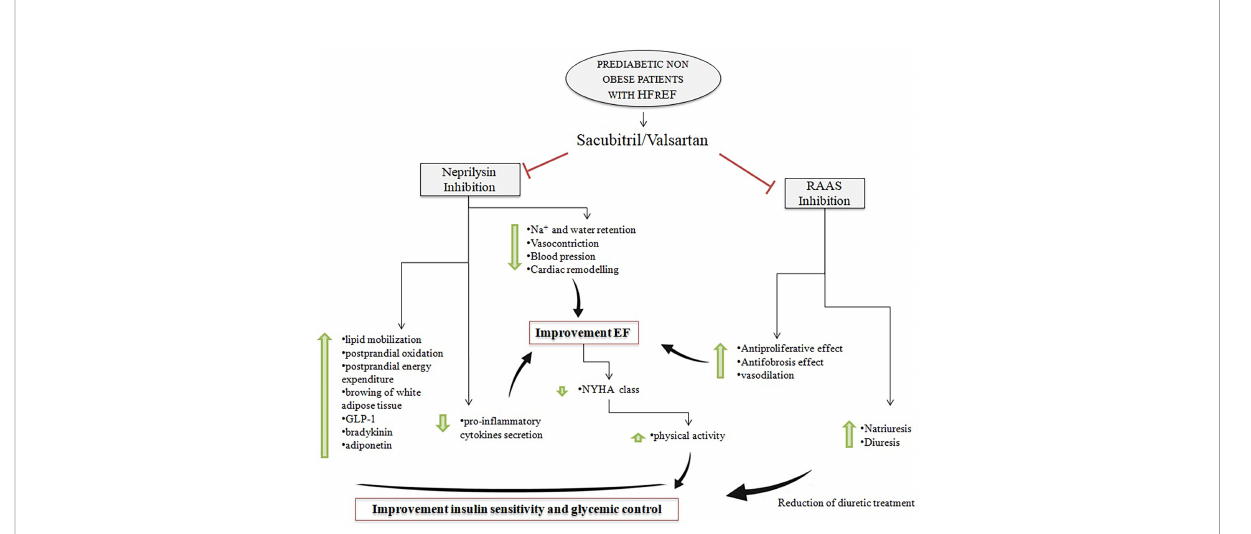
FIGURE 1 Effects of neprilysin inhibition and RAAS inhibition on insulin sensitivity and EF in prediabetic non-obese patients with HFrEF in treatment with sac/val. RAAS, renin – angiotensin – aldosterone system; EF, ejection fraction; HFrEF, heart failure with reduced ejection fraction; sac/val,